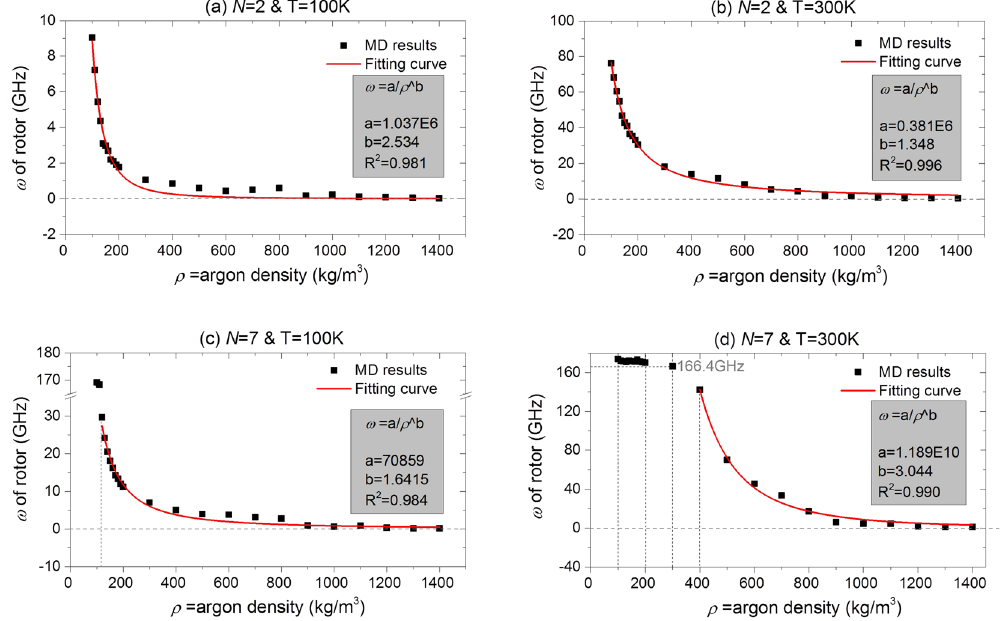
Figure 3. SRFs of rotor under different conditions. ( a ) A nanomotor with N = 2 is used, and the temperature (T) is 100 K, ( b ) N = 2 & T = 300 K, ( c ) N = 7 & T = 100 K, ( d ) N = 7 & T = 300 K.